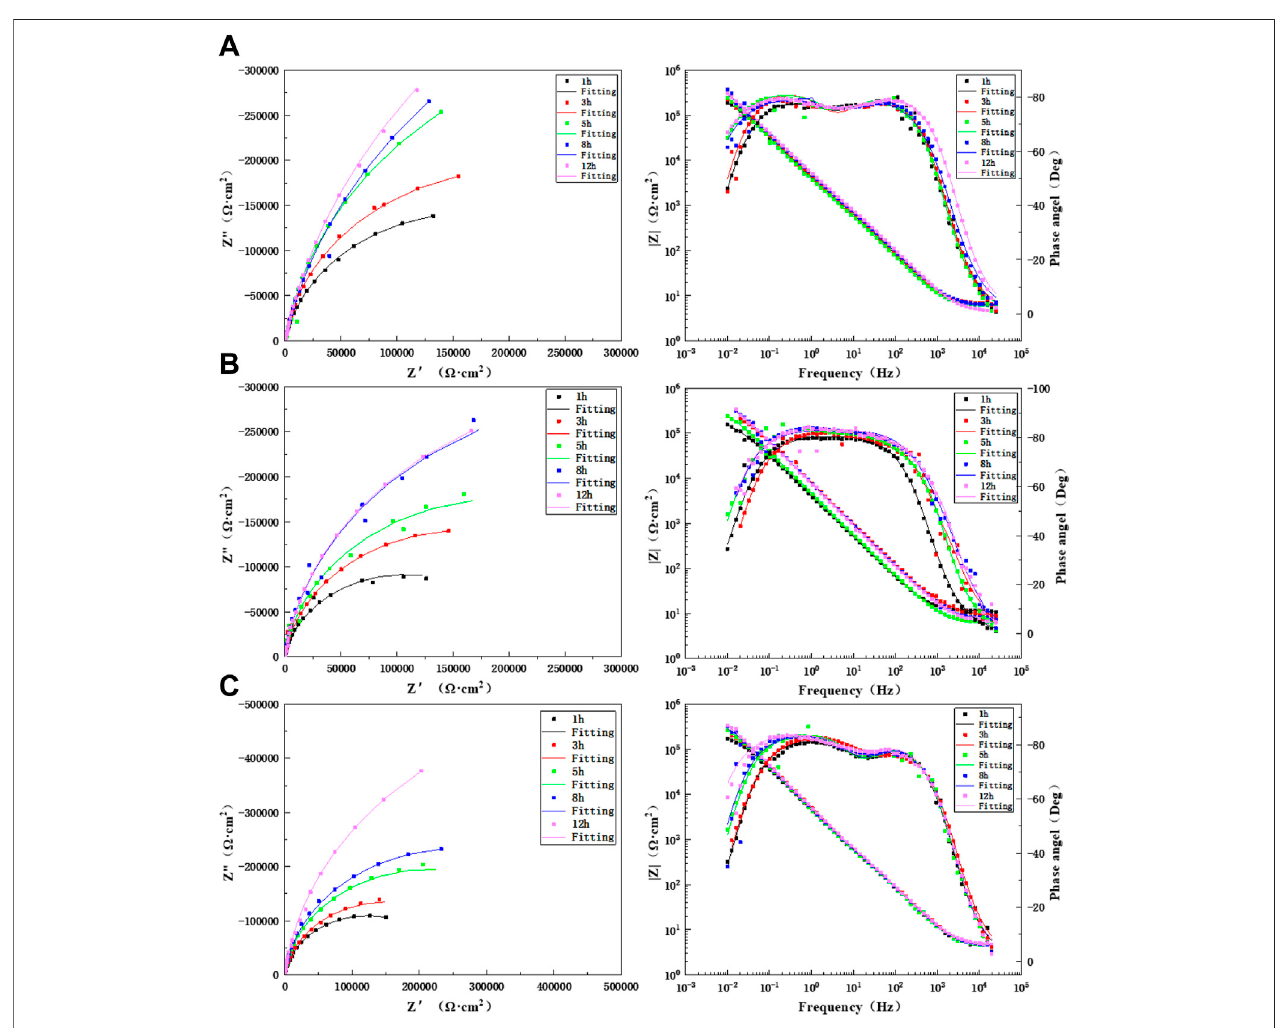
FIGURE 8 | Impedance changes in the HAZ during 12 h of scouring in arti fi cial seawater: (A) 1.85 m/s, (B) 3 m/s, and (C) 6 m/s.